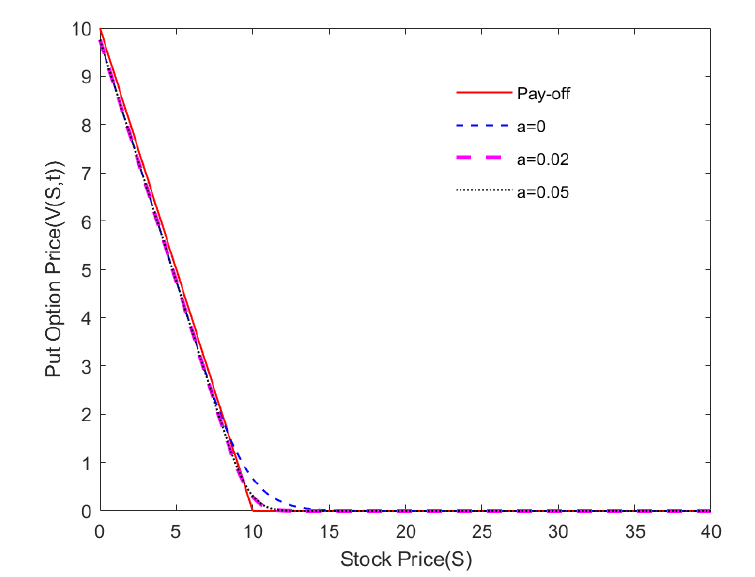
Figure 4. Valuation of the European put option in both linear and nonlinear